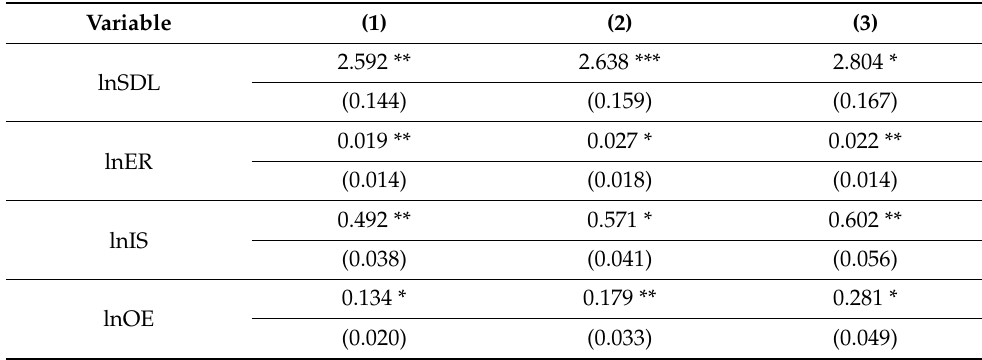
Table 9. Robustness test